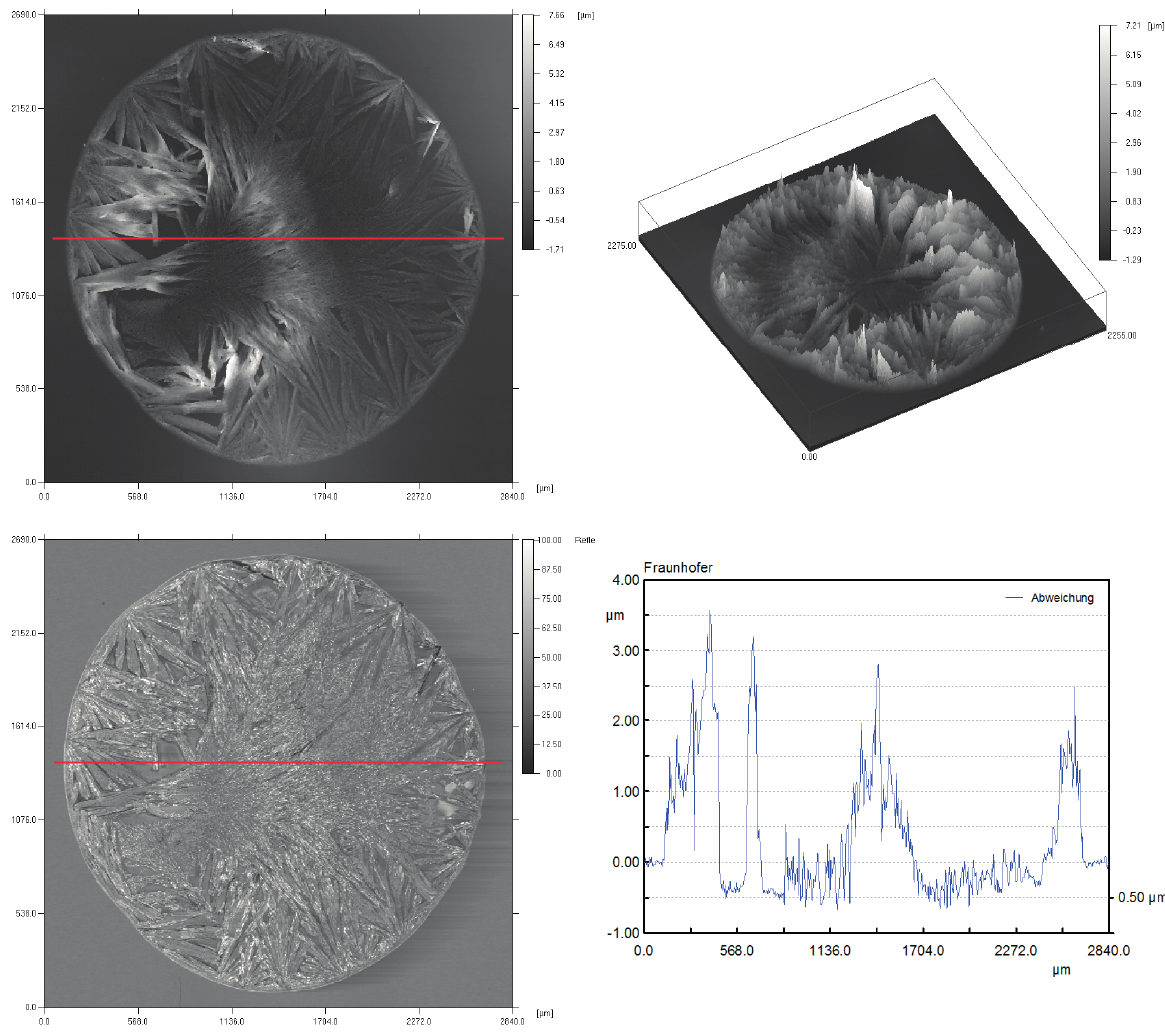
Figure 4. Profilometry results of the CF-But-90-10 drop using a NanoFocus µscan ® . It